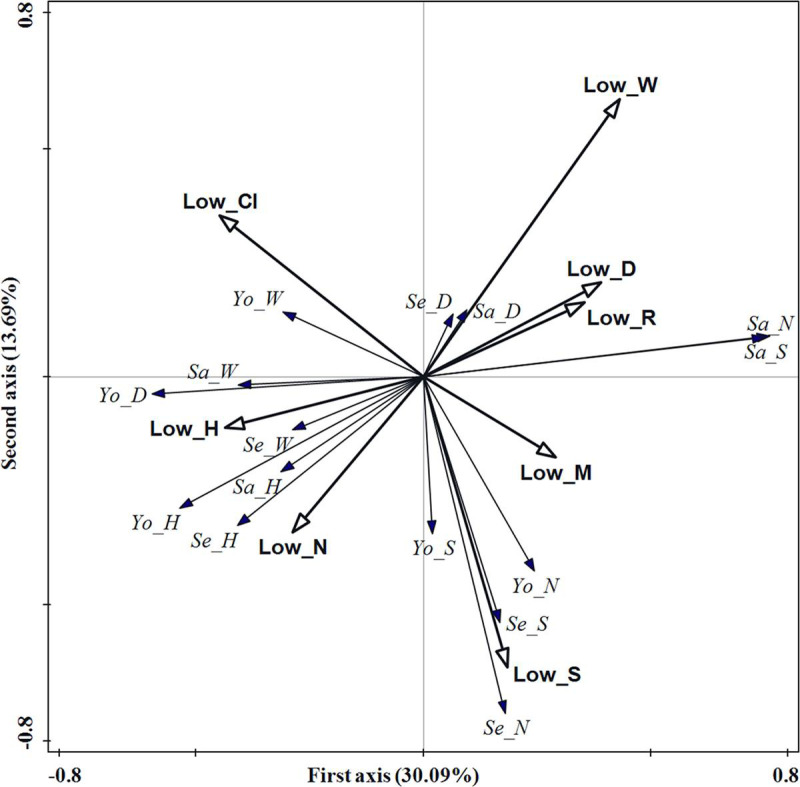
RDA ordination diagram of lower forest stratum structure indices
and regeneration in the evergreen broad-leaved forest.Hollow arrows represent stand structure indices and solid arrows
represent regeneration indicators. Low_M, Low_CI, Low_R, Low_S,
Low_DBH, Low_H, Low_W and Low_N denote the mingling, competition
index, aggregation index, tree species richness index, diameter at
breast height, tree height, crown width and density, respectively.
Se_N, Se_D, Se_H, Se_W and Se_S denote seedling density, basal
diameter, tree height, crown width and tree species richness index,
respectively; Sa_N, Sa_D, Sa_H, Sa_W and Sa_S denote sapling
density, basal diameter, tree height, crown width and tree species
richness index, respectively; Yo_N, Yo_D, Yo_H, Yo_W and Yo_S denote
young tree density, diameter at breast height, tree height, crown
width and tree species richness index, respectively.